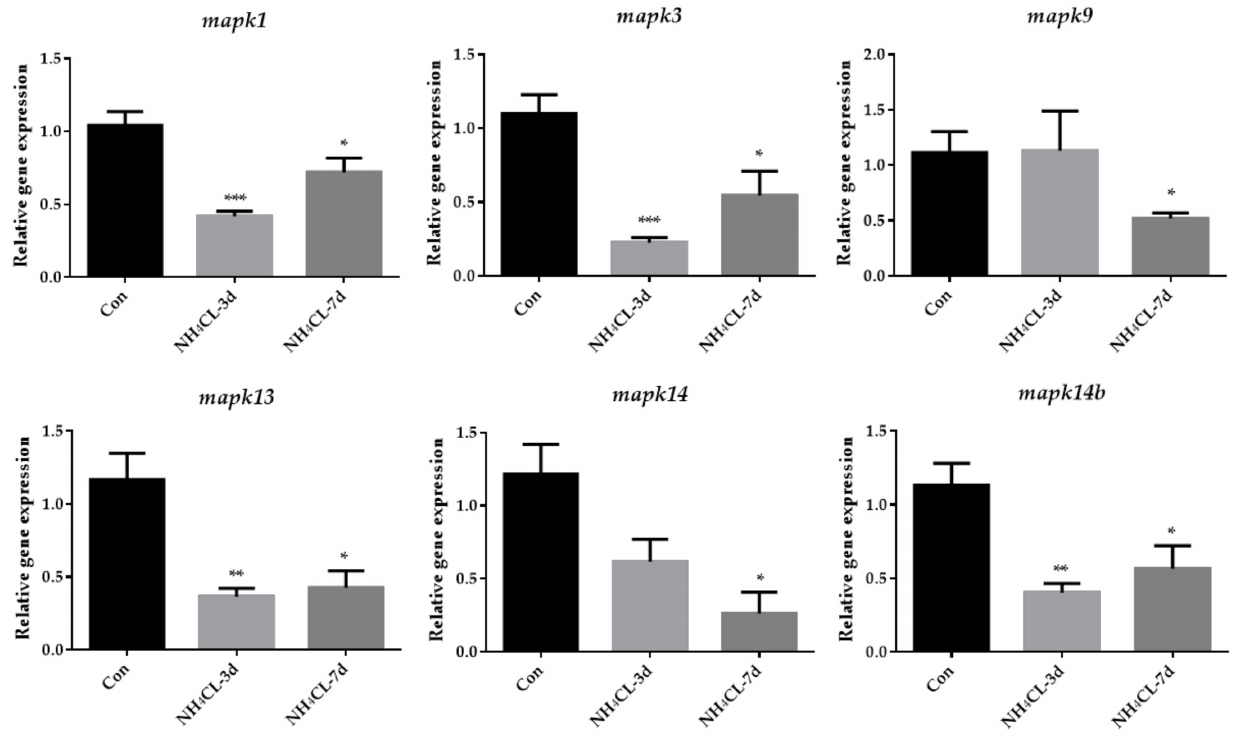
Figure 9. The expression of genes related to MAPK pathway ( mapk1 , mapk3 , mapk9 , mapk13 , mapk14 and mapk14b ) in largemouth bass liver after ammonia exposure for 3 days and 7 days was affected. All data were analyzed with Student’s t -test and data were mean ± SEM ( n = 6). * p < 0.05; ** p < 0.01; *** p <